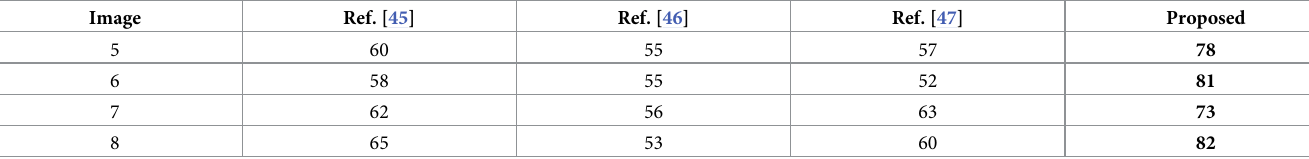
Table 16. Comparison of various contrast enhancement techniques using MOS.